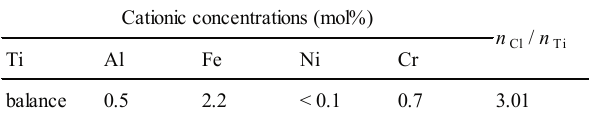
Table 2. Results of analyses of the separated TiCl 3 .